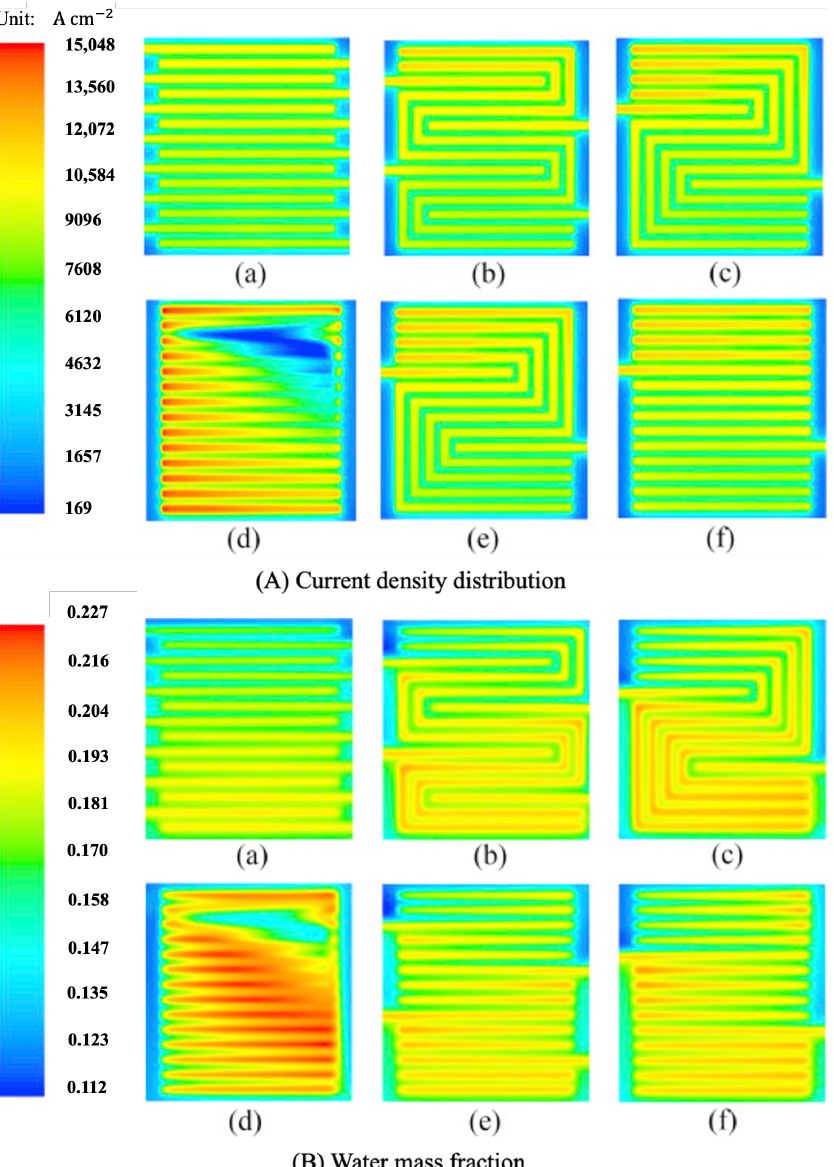
Figure 9. The distribution of ( A ) current density and ( B ) water mass fraction at the cathode of ( a ) 1S, ( b ) 3S, ( c ) 5S, ( d ) parallel, ( e ) 3PIS and ( f ) 5PIS